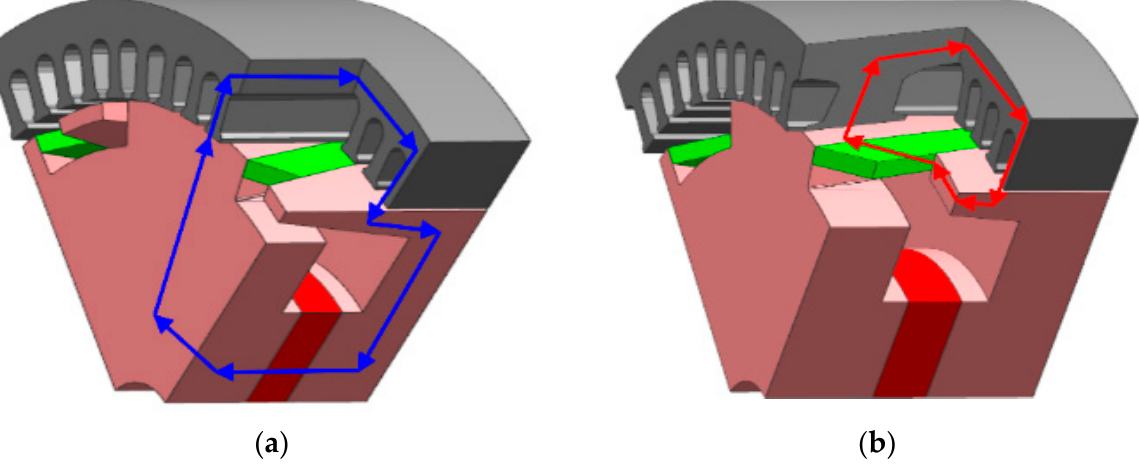
Figure 3. Schematic diagram of the main magnetic circuit of claw pole generator. ( a ) The first main magnetic circuit; ( b ) the second main magnetic circuit.